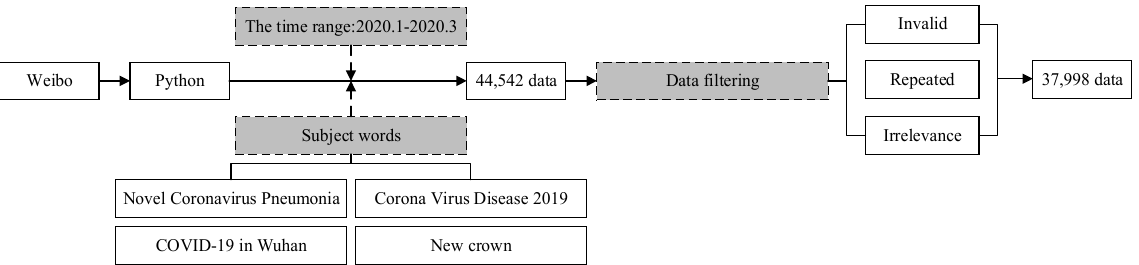
Figure 7. The process of data collection of microblog contents on the Sina Weibo platform.